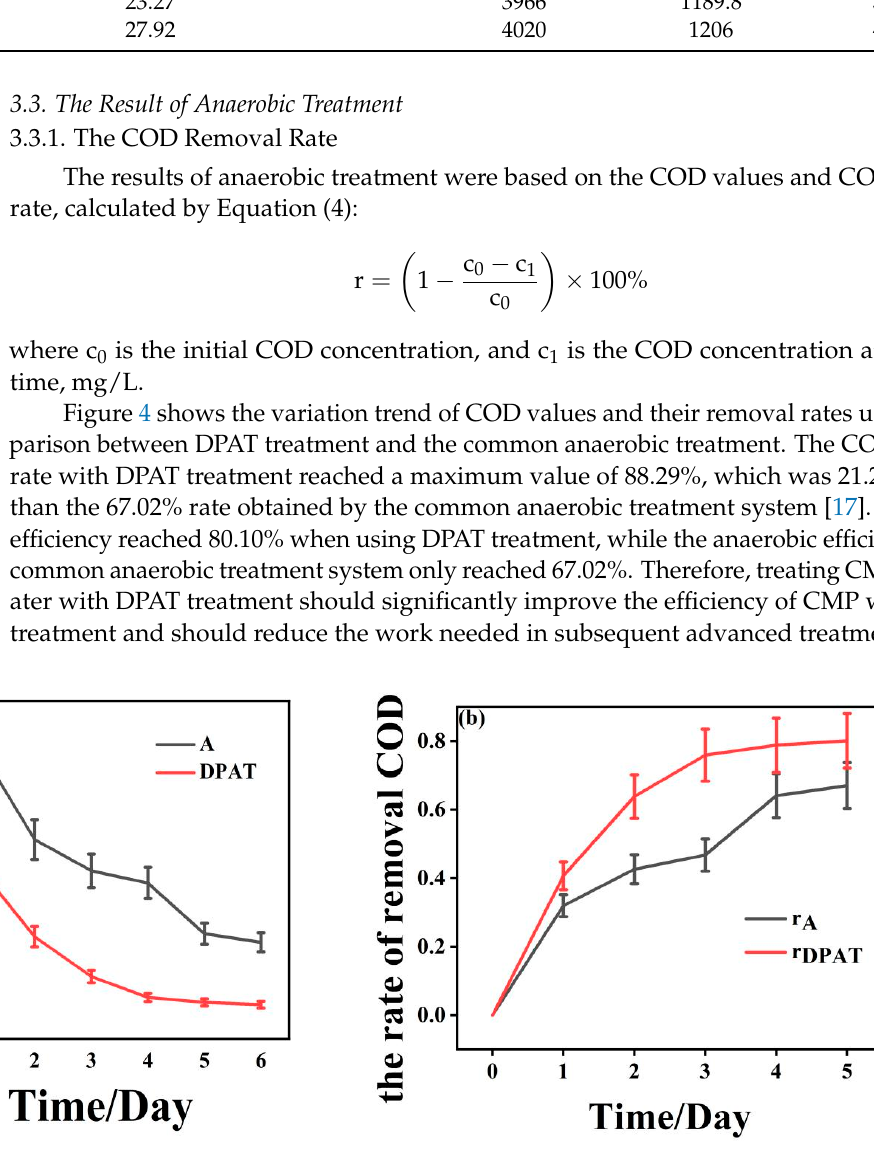
Figure 4. The change in COD values ( a ) and their removal rates ( b ). A and DPAT represent the variation trend of COD under different systems. r A and r DPAT represent the changing trend of COD removal rate under different systems.